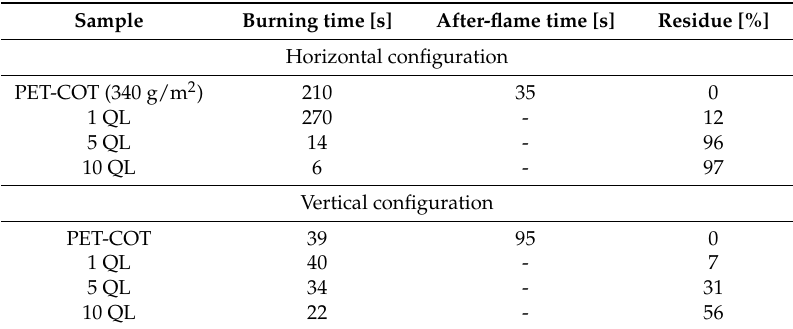
Table 14. Combustion data of untreated and QL-treated PET-COT fabrics by horizontal and vertical flame spread tests [29].